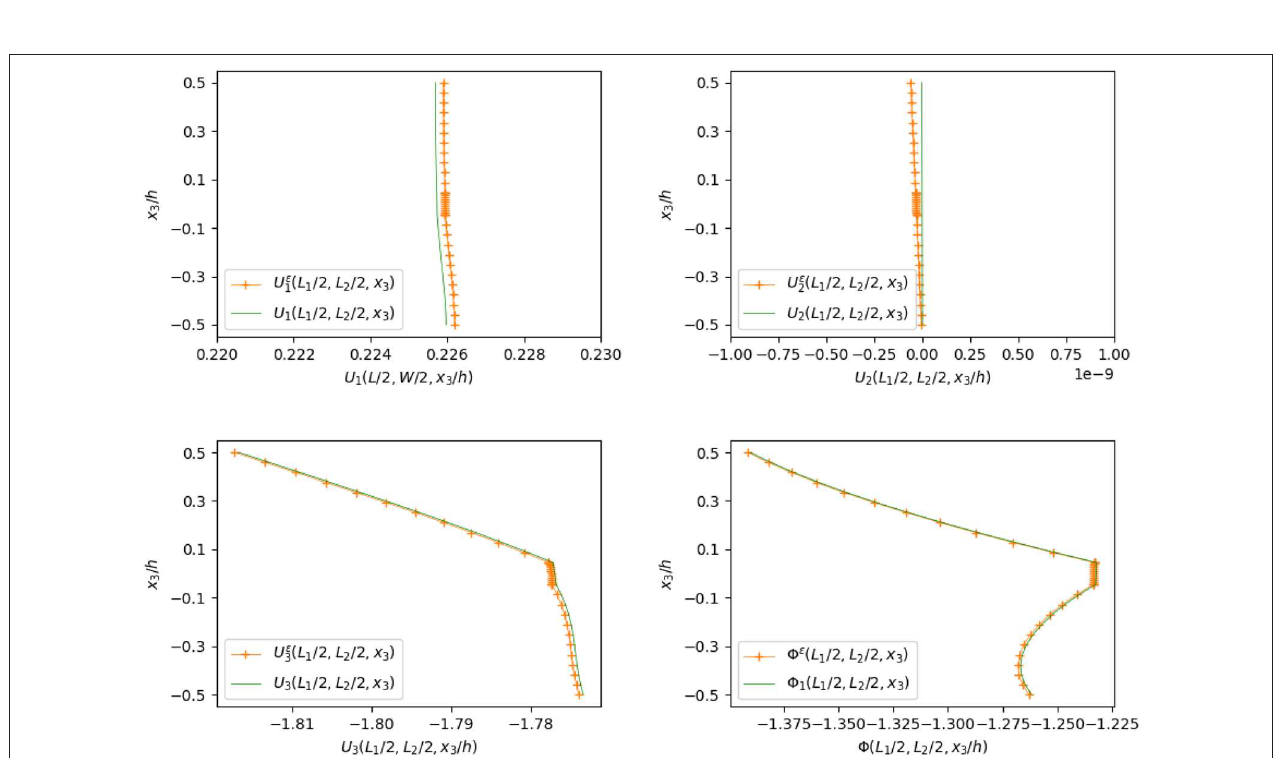
FIGURE 9 | Displacement field and electric potential on a section along the x 3 axis, with ε/ h = 0.1.